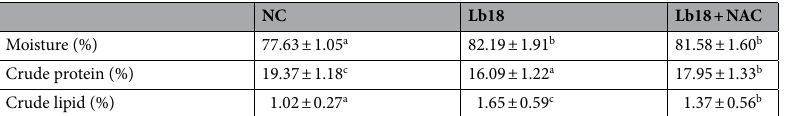
Table 4. Effects of infection with P. vulgaris and E. meningoseptica on muscle composition of Chinese soft- shelled turtles. Values represent the mean ± S.E. (n = 3 replicate tanks), 3 turtles were sampled for each tank. Values within the same row having different superscripts are significantly different ( p <